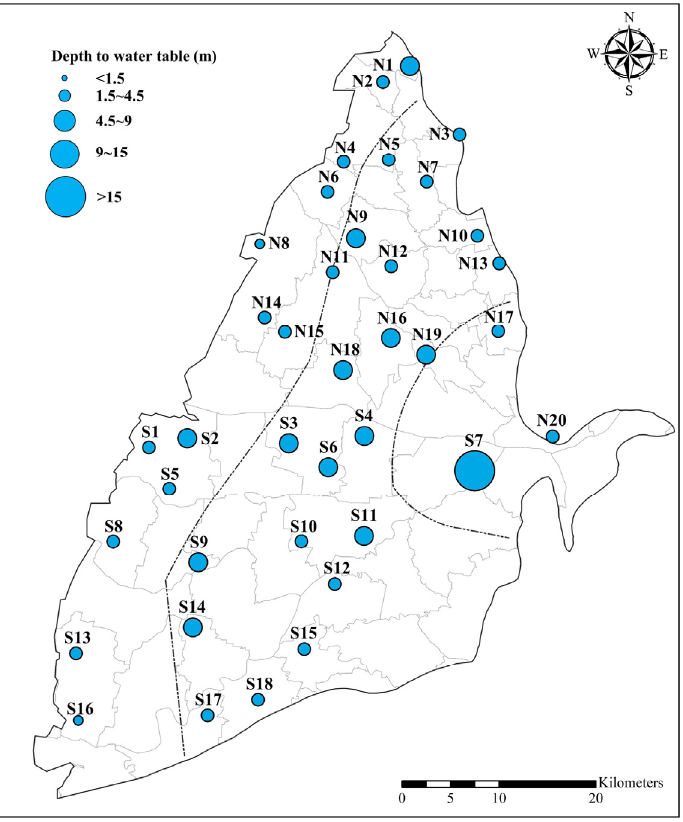
Figure 2. Range of depth to water table for each monitoring well from 2018 to 2020 in the study area.